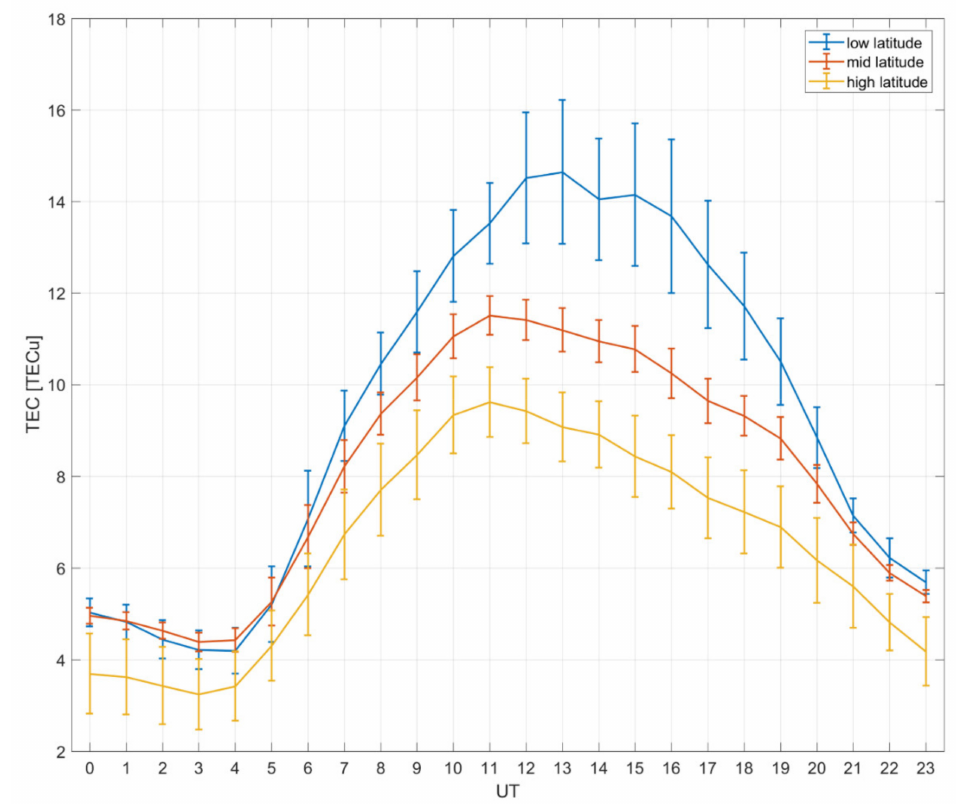
Figure 6. Mean daily variation of the TEC for Italian low (blue), mid (orange) and high (yellow) latitudes for the period 1 May 2017 to 30 April 2020. The error bars represent the TEC standard